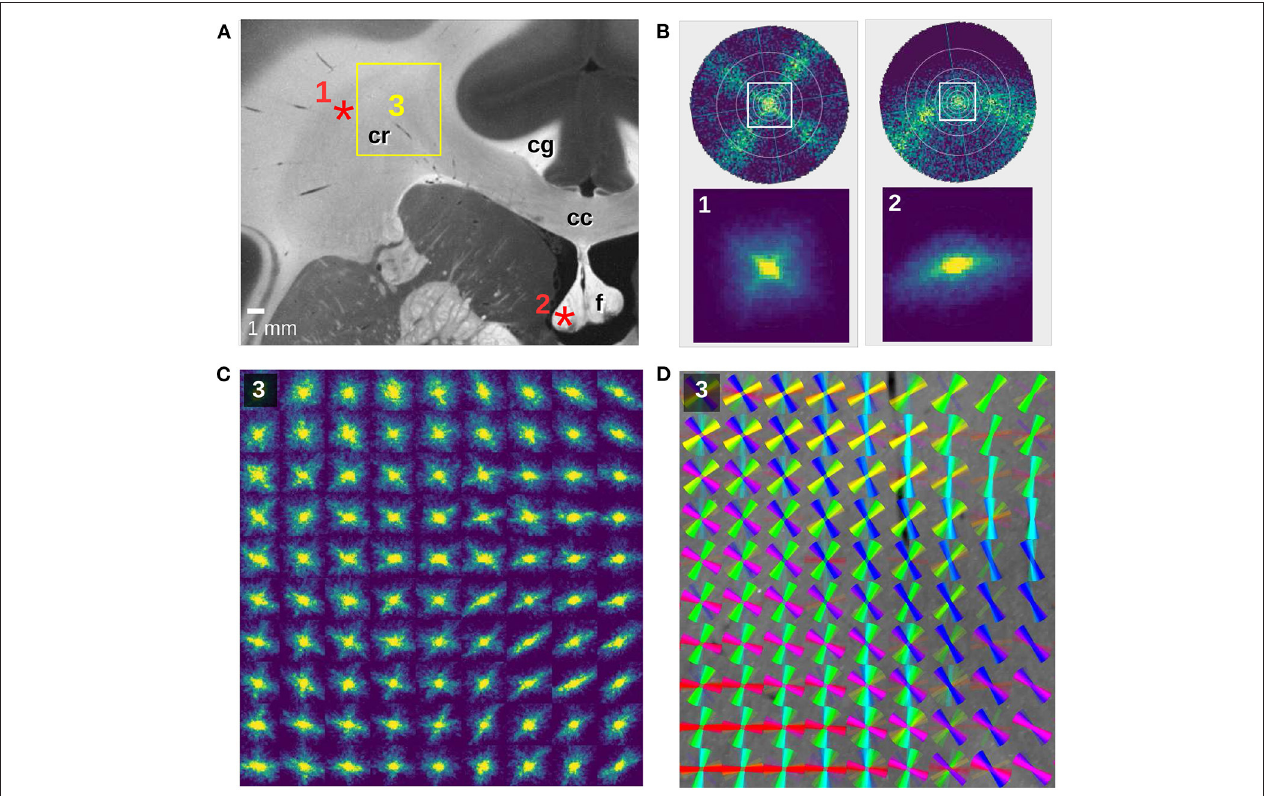
FIGURE 7 | SLI scatterometry measurements of a coronal vervet monkey brain section (section 493). (A) Averaged scattered light intensity with labeled anatomical structures: corpus callosum (cc), cingulum (cg), corona radiata (cr), fornix (f). (B) Scattering patterns for two crossing fiber bundles (left) and an out-of-plane fiber bundle (right). The top images show the simulated scattering patterns obtained from finite-difference time-domain simulations of two 90 ◦ -crossing, interwoven fiber bundles and a 50 ◦ -inclined fiber bundle (adapted from Menzel et al., 2020, Figure 7). The bottom images show the measured scattering patterns for an image pixel in the corona radiata (1) and in the fornix (2), indicated by the red asterisks in (A) . The SLI scatterometry measurement was performed 10 months after tissue embedding with 4 × 4 illuminated LEDs, 40 × 40 kernels, gain factor 10, and illumination 10 s. (C) Scattering patterns of the rectangular region in (A) , shown for every 150 th image pixel (px = 3 µ m). The SLI scatterometry measurement was performed 15 months after tissue embedding with one illuminated LED, 50 × 50 kernels, gain factor 27, and illumination 10 s. (D) Fiber orientation distribution map of the same region: the fiber orientations were computed with SLIX from every 15 th scattering pattern and displayed on top of each other as colored lines for every 10 × 10 scattering